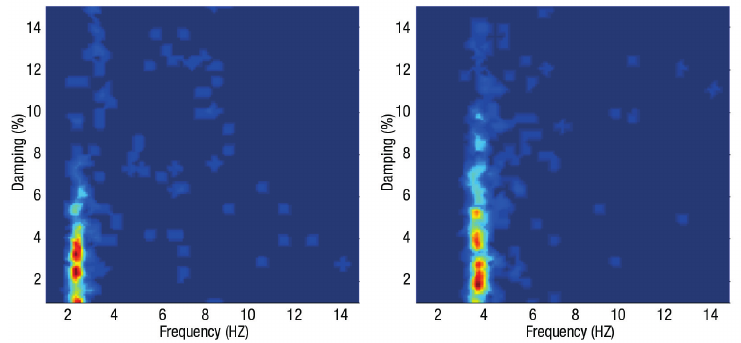
Fig. 7. NonPaDAn estimate of frequency and damping for a 4 stories R.C. Building in potenza, Italy with the bare frame only ( left ) and completed with infills ( right ).